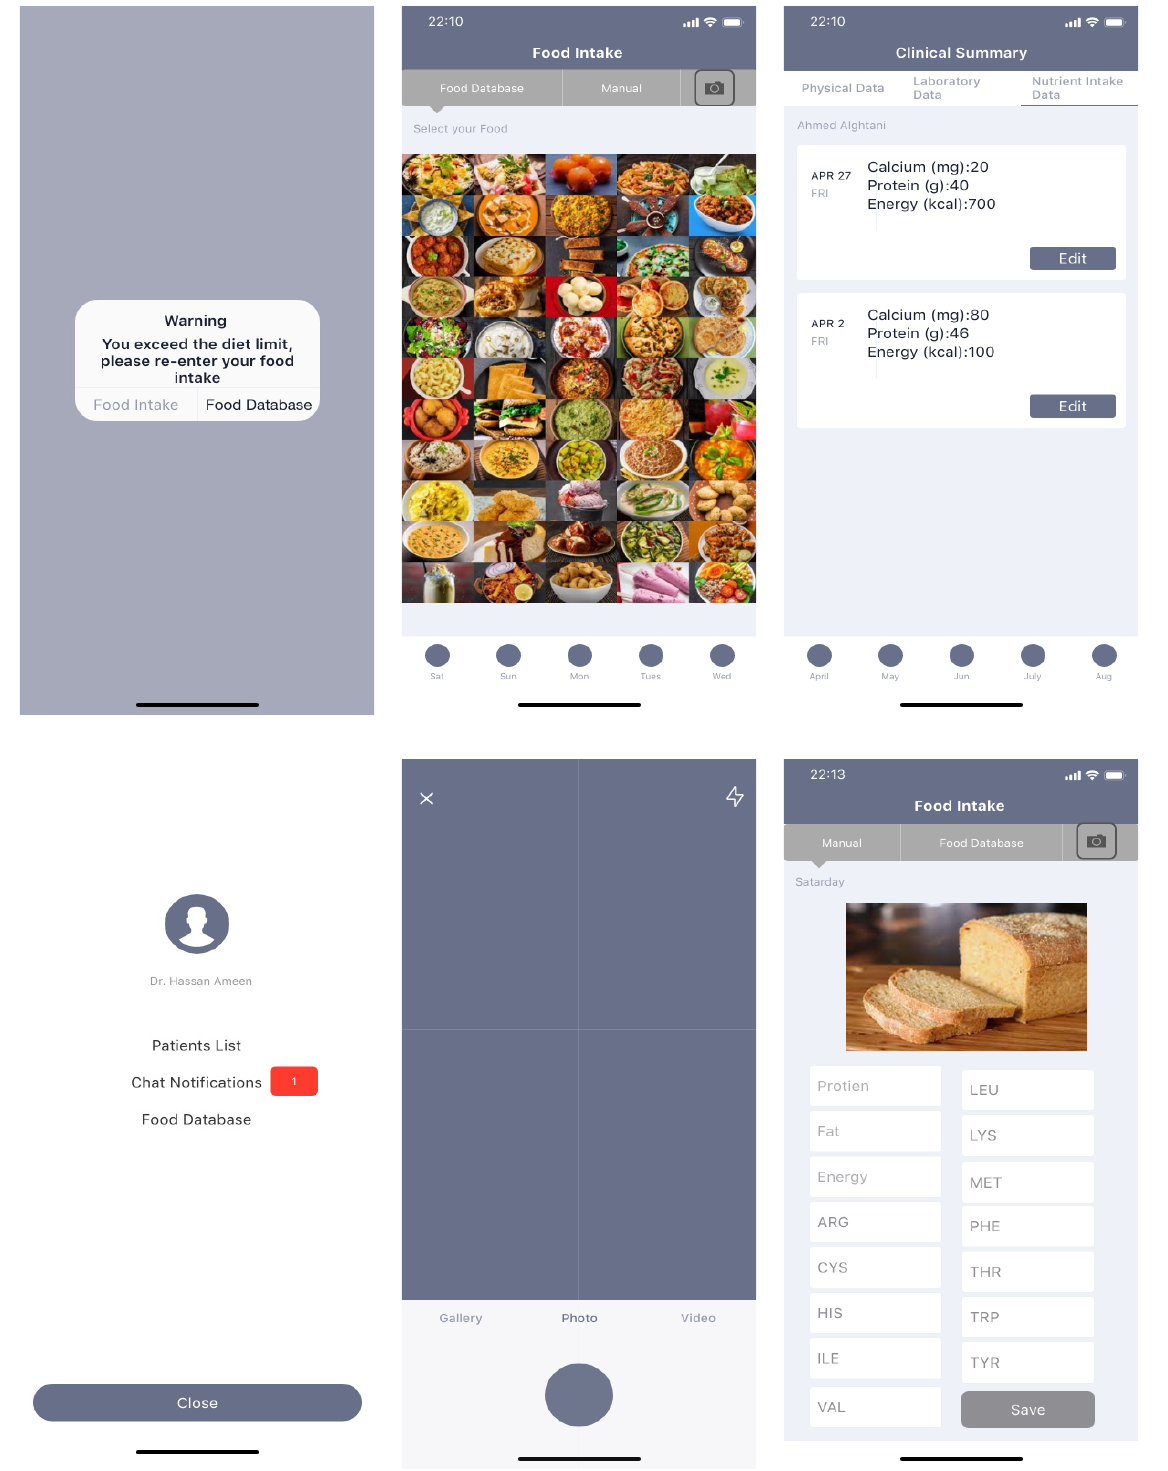
Figure 2. User interface for the mobile application to support MSUD patients and clinicians.